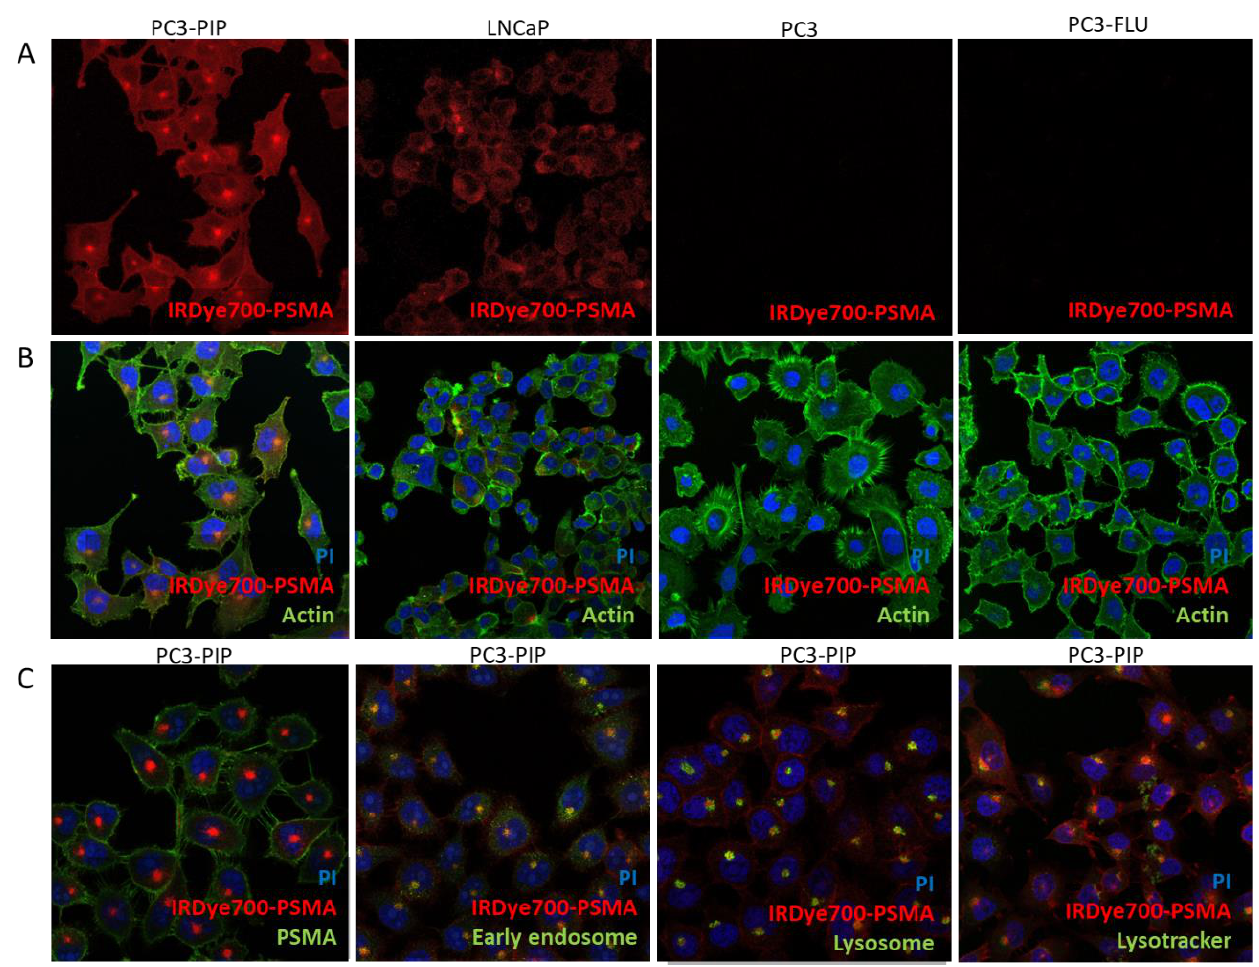
Figure 3. ( A ) Uptake and cellular distribution in PC3-PIP, LNCaP, PC3 and PC3-FLU of IRDye700DX-PSMA in red; ( B ) actin in green and nuclei in blue; ( C ) PC3-PIP cells incubated with IRDye700DX-PSMA in red and nuclei in blue, in green, respectively PSMA, early endosome, lysosome and lysotracker. Magnification 40×, PI 535 – 617 nm, AlexaFluor488 498 – 577 nm, IRDye700DX 650 – 750.